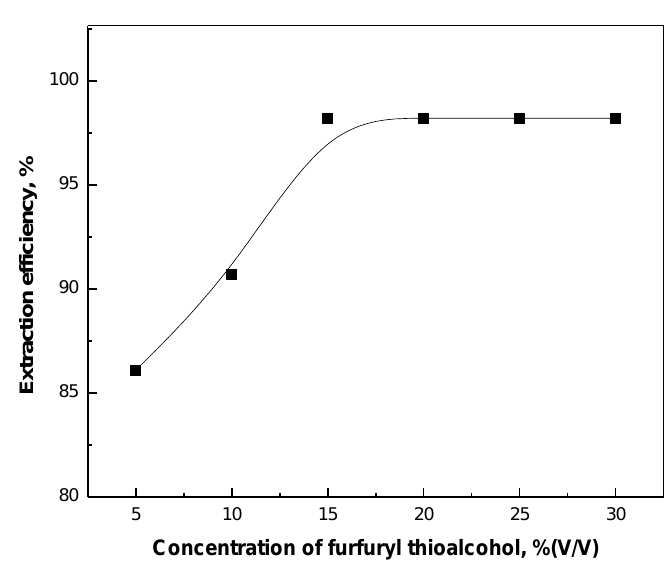
Fig. 3 . Effect of furfuryl thioalcohol concentration on the extraction of copper, Conditions: pH 5.5, O/A = 1, Na 2 SO 4 = 0.5 mol L -1 , equilibrium time = 10 minutes.